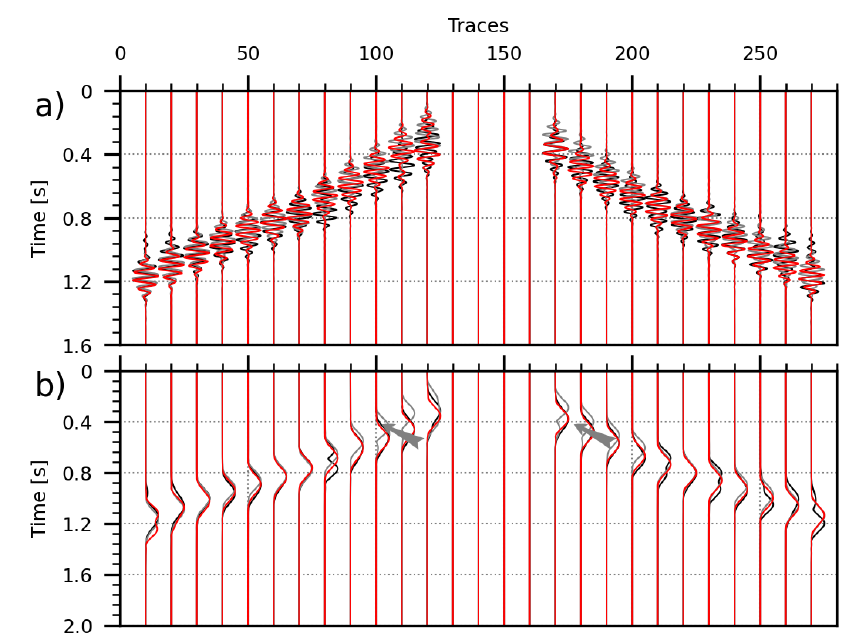
Figure 16. ( a ) Comparison of the observed data (black lines), synthetic data calculated with the initial model and wrong source (gray lines), and synthetic data calculated from the inverted model (Figure 13b) and wrong source (red lines); ( b ) comparison of the envelopes of observed data (black lines), synthetic data calculated with the initial model and wrong source (gray lines), and synthetic data calculated from the inverted model (Figure 13d) and wrong source (red